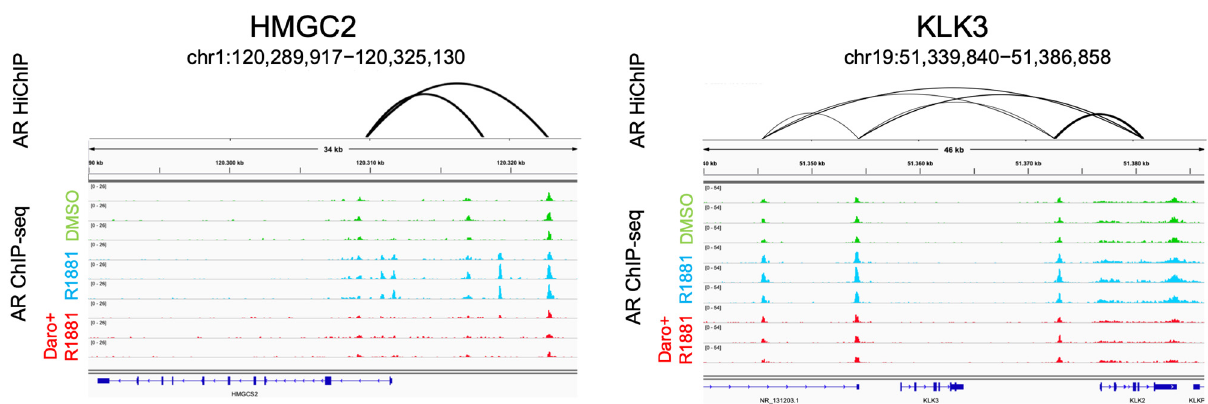
Figure 6. Determination of AR peaks and AR-mediated loops around selected gene regions in VCaP cells treated with DMSO, androgen, or androgen and darolutamide. ( A ) AR HiChIP and ChIP-seq results for genes with divergent regulation of RNA and protein levels. ( B ) AR HiChIP and ChIP-seq results for genes with parallel regulation of RNA and protein levels. Loop intensities are reflected by the thickness of the